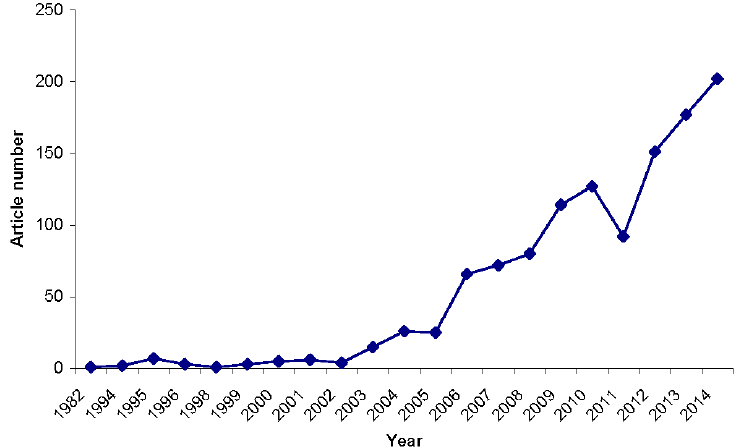
Figure 1. Evolution of the theme “open access” in